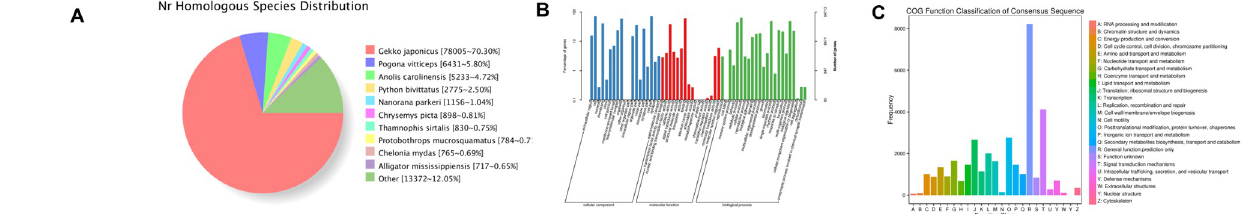
Fig 2. (A) The species identified by a homology search against the Nr databases. (B) GO annotation and (C) COG annotation of the G . gecko transcriptome.